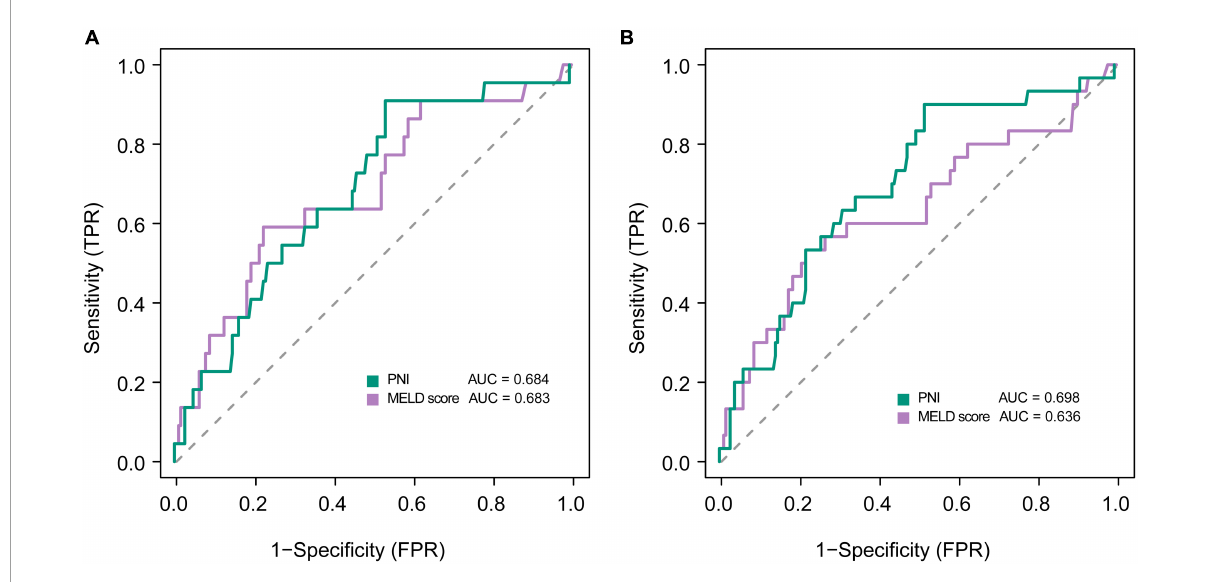
FIGURE2 Receiver operating curves showing predictive accuracy of the MELD score and the PNI for mortality at (A) 3, and (B) 6 months in patients with decompensated liver